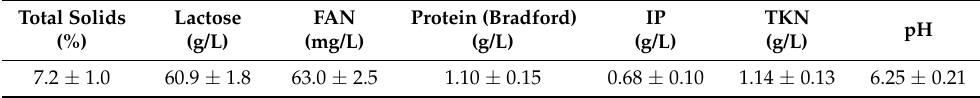
Table 1. Characteristics of centrifugated and filtrated second cheese